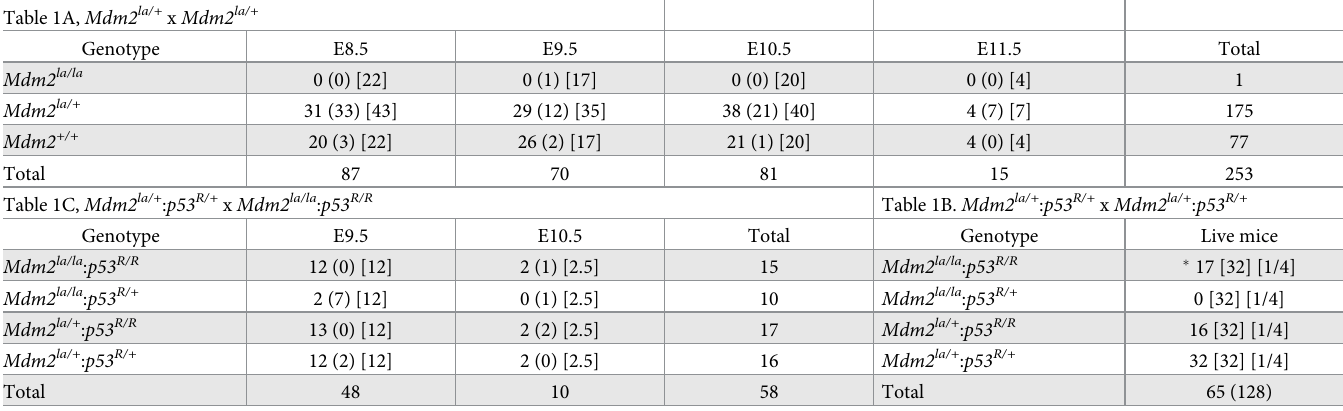
Table 1. The timing of Mdm2 la/la embryonic lethality and rescue by Trp53 deletion. ( A ), Viable embryos at the indicated days post conception from inter-mating of Mdm2 la/+ heterozygotes. ( B ), Live mouse counts from inter-mating of Mdm2 la/+ : p53 R/+ heterozygotes. ( C ), Viable embryos at the indicated days post conception from inter-mating of Mdm2 la/+ : p53 R/+ with Mdm2 la/+ : p53 R/R mice. n = number of live embryos; (n) = number of dead/resorbed embryos; [n] = Expected Mendelian frequency. Table 1A, Mdm2 la/+ x Mdm2 la/+